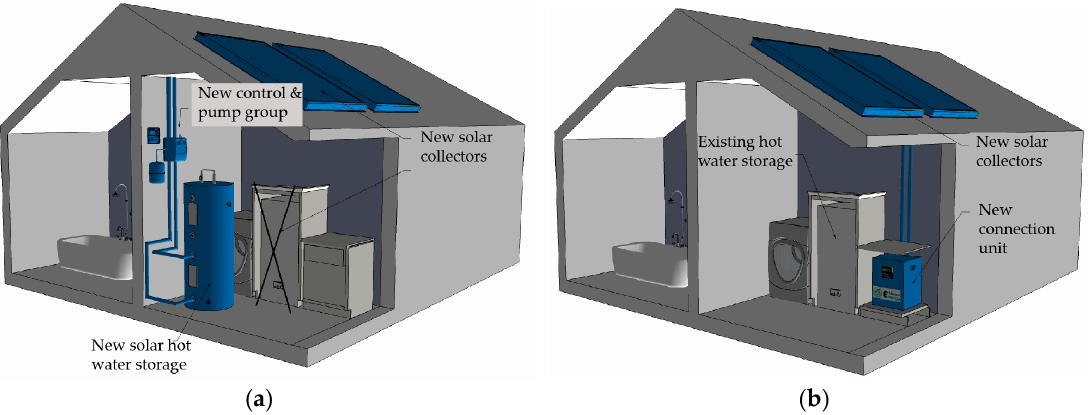
Figure 1. ( a ) Conventional solar domestic hot water system, commonly featuring a solar storage with a heating coil at the bottom and an electric heater at the top; ( b ) Retrofitting the existing electric